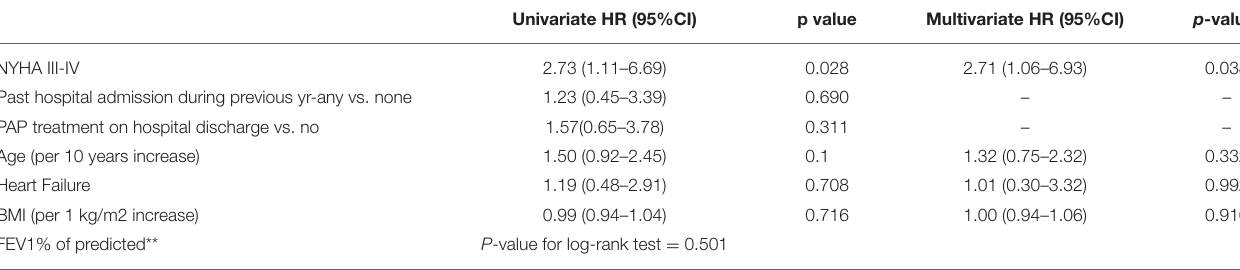
TABLE 2 | Risk Factors for Adverse Outcome Following ICU discharge tested in Cox univariate and Cox multivariate